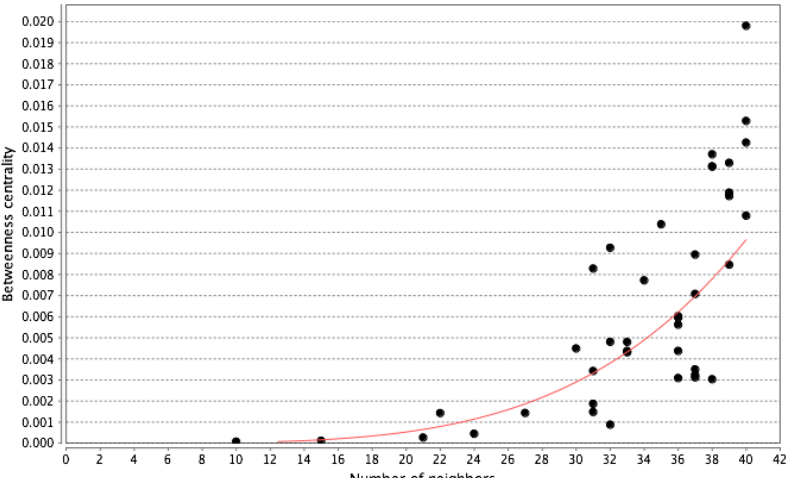
Figure 9 . Betweenness centrality of the Apps relations